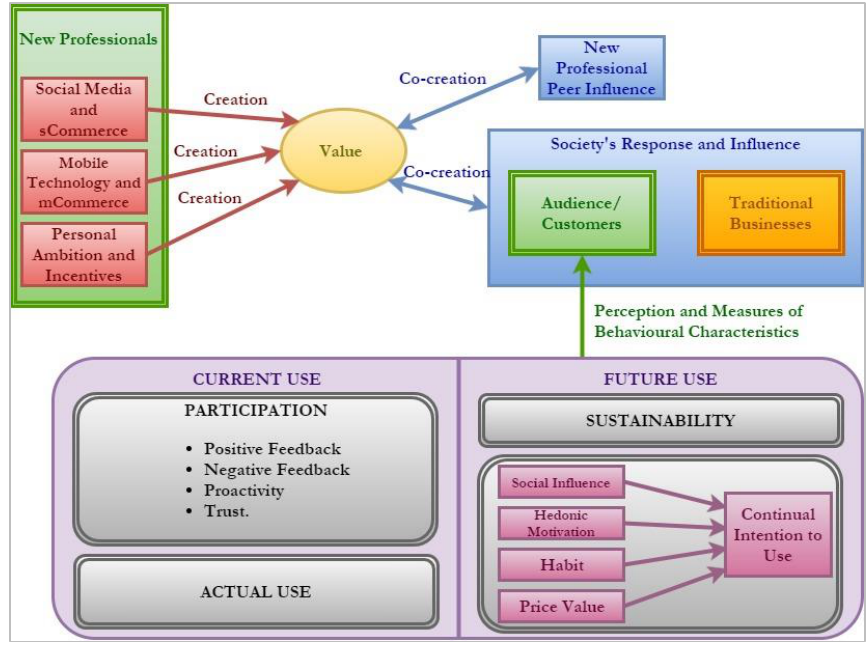
Figure 4. Value creation and co-creation and audience/customer perceptions and behavioral char- acteristics.